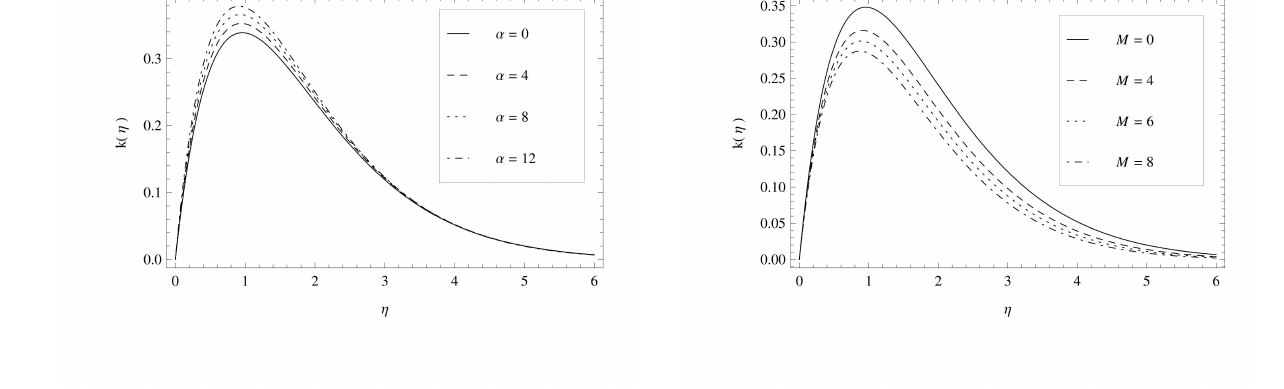
Fig. 12: The influence of a parameter α on k ( η ) for We = 0.2, λ = 0.1, M = 0.4, f = 0.7, (cid:126) = −0.01 w